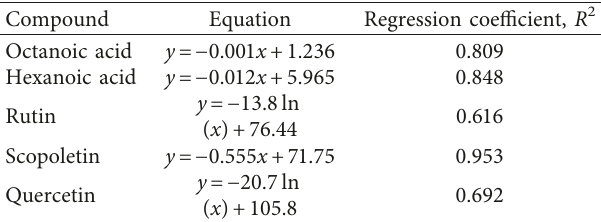
Table 6: Equation and regression coefficient of Peleg’s rate con- stant for organic acids (octanoic acid and hexanoic acid) and phenolic compounds (scopoletin, quercetin, and rutin) at different initial concentrations.